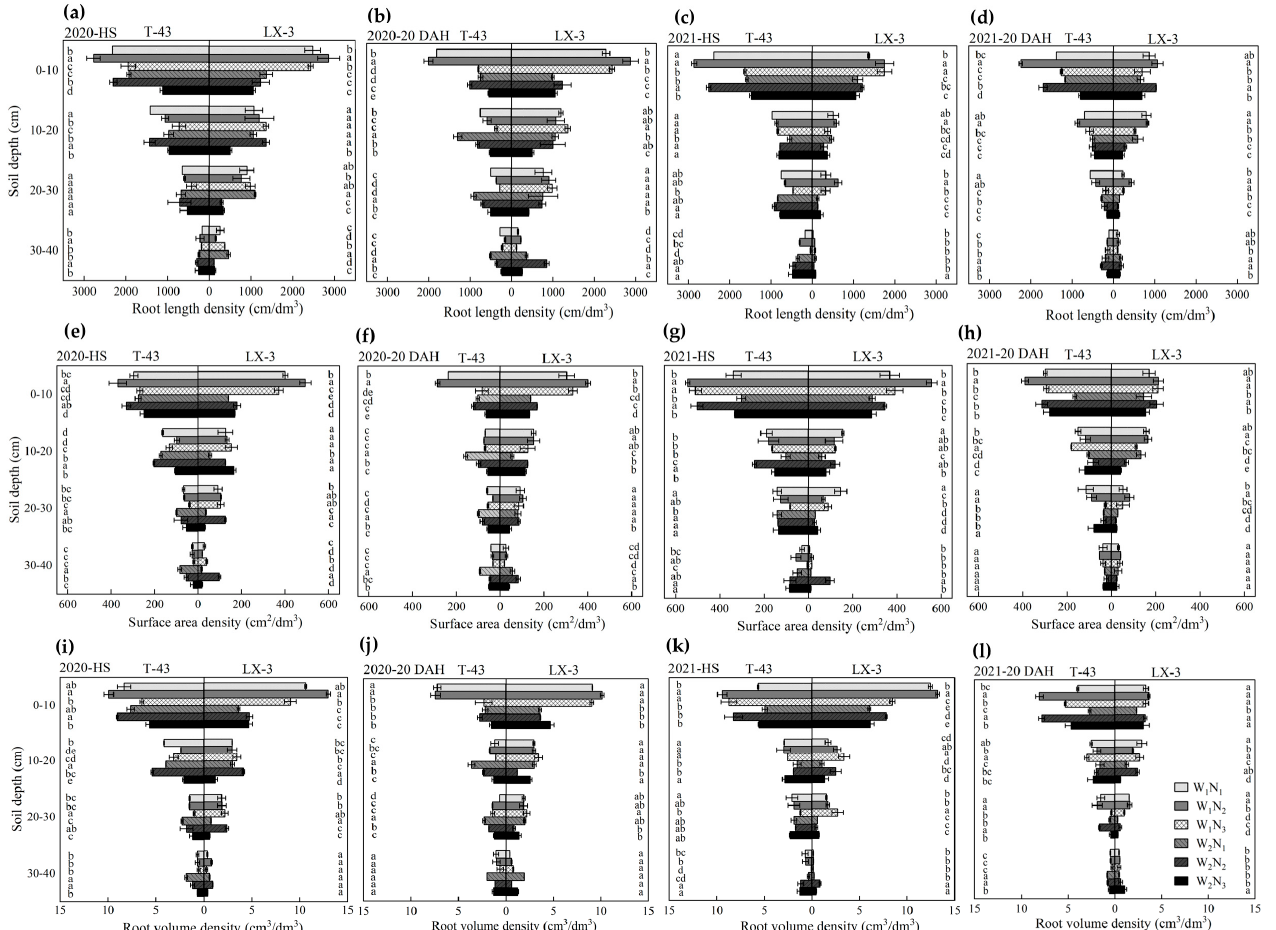
Figure 4. E ff ects of water and nitrogen management on spatial distribution characteristics of